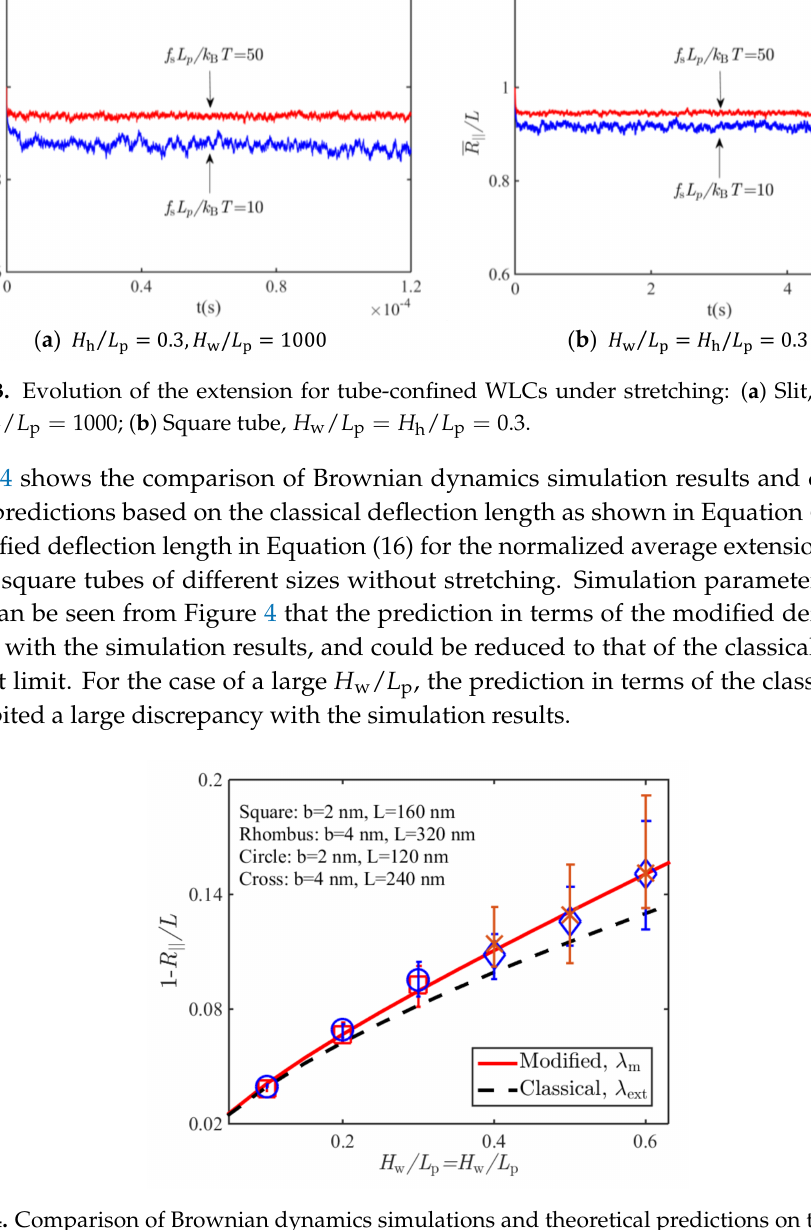
Figure 4. Comparison of Brownian dynamics simulations and theoretical predictions on the relative average extension of a WLC under confinements of square